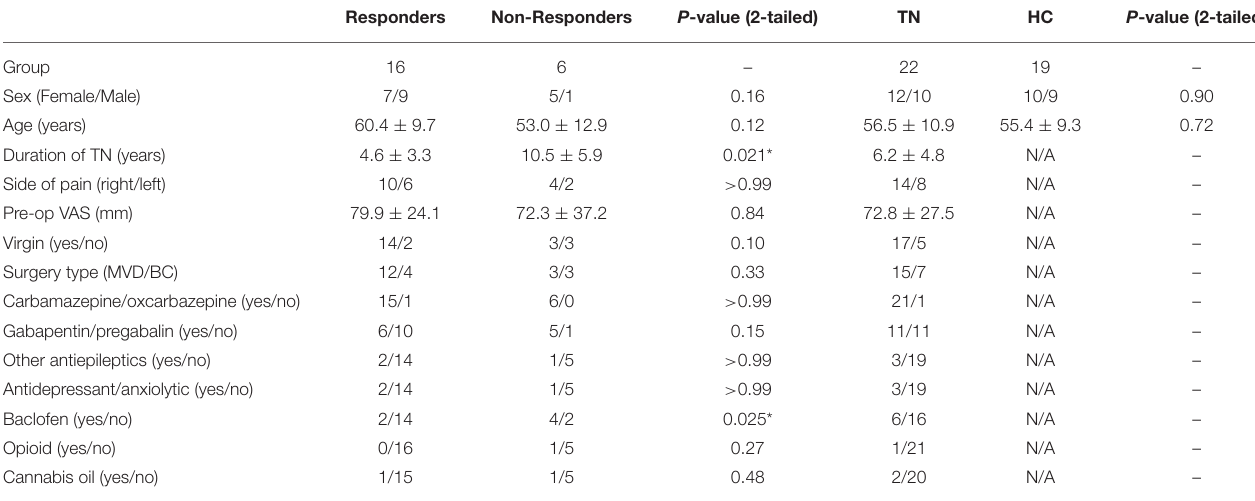
TABLE 1 | Comparison of demographic and clinical characteristics between TN patients (including responders and non-responders) and healthy controls. Responders Non-Responders P -value